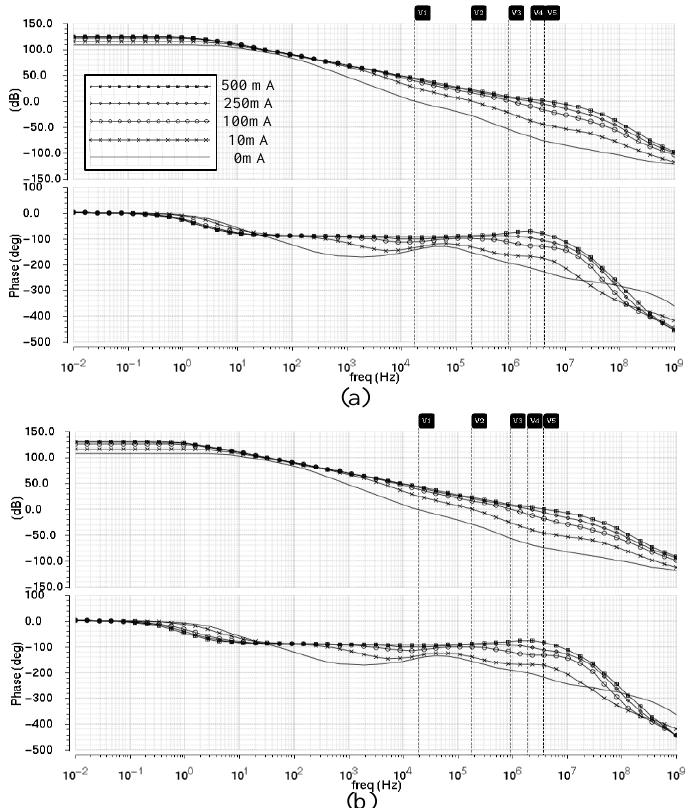
Figure 6. Simulated loop response results of the linear regulator core with different current loads; ( a ) supply voltage of 3.9 V; ( b ) supply voltage of 10 V.